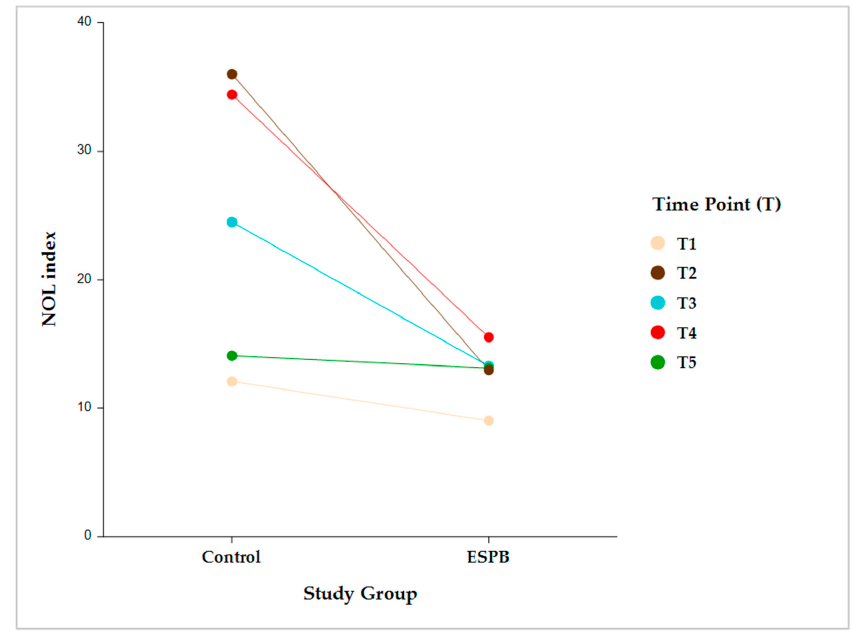
Figure 3. Intergroup comparison (Control vs. ESPB) by time for the NOL index value. The data are presented as least square adjusted means. Time points: T1 (pre-incision), p = 0.759; T2 (post-incision), p < 0.001; T3 (pre-sternotomy), p < 0.001; T4 (post-sternotomy), p < 0.001; T5 (pre-CPB), non-significant. Analysis was performed using a mixed model for repeated measurement with random intercepts for patients and fixed effects for group, time, and the interaction of group and time. CPB, cardiopulmonary bypass; ESPB, erector spinae plane block; NOL, nociception level. Intragroup comparisons were performed in each group between two consecutive time points (i.e., pre-incision vs. post-incision; post-incision vs. pre-sternotomy; pre-ster- notomy vs. post-sternotomy; and post-sternotomy vs. pre-CPB) (Figure 4).